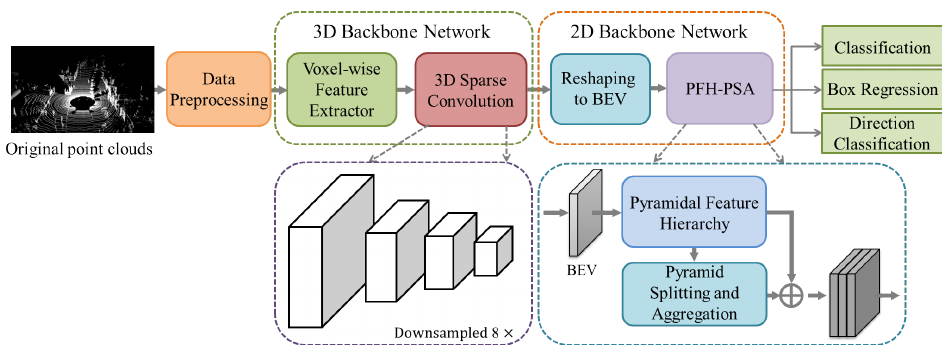
Figure 1. The structure of our PSANet. The detector divides the original point cloud space into regular voxels and extracts voxel-wise features by using a mean voxel-wise feature extractor. Af- ter the 3D sparse convolutional middle extractor learns the information along the Z -axis, the 3D sparse data is converted into a dense 2D bird’s eye view (BEV) pseudo-image. Finally, PFH-PSA completes the cross-layer fusion of multi-scale BEV features and obtains more expressive features for subsequent